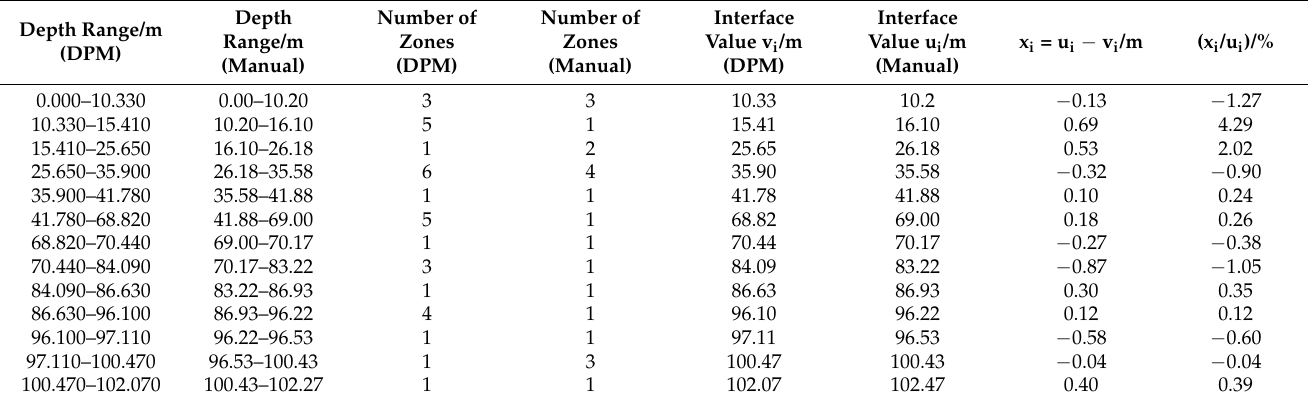
Table 3. Interface depth and zoning comparisons of DPM cataloguing and manual cataloguing for a borehole in Yan’an